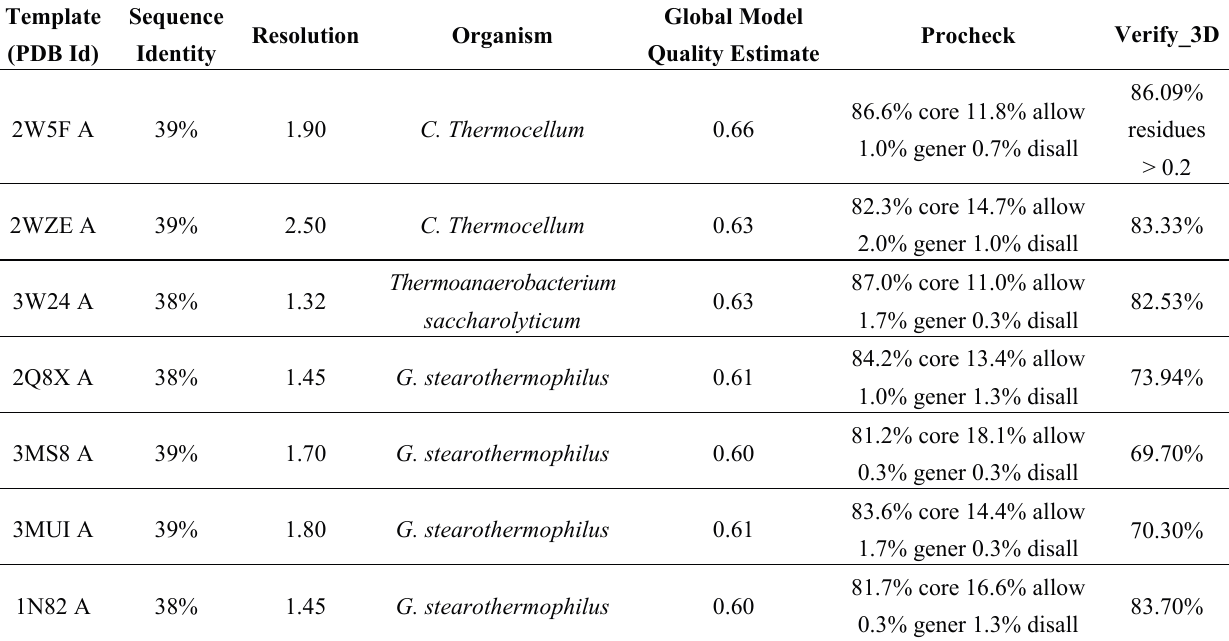
Table 1. The estimates of the expected accuracy of the resulting models